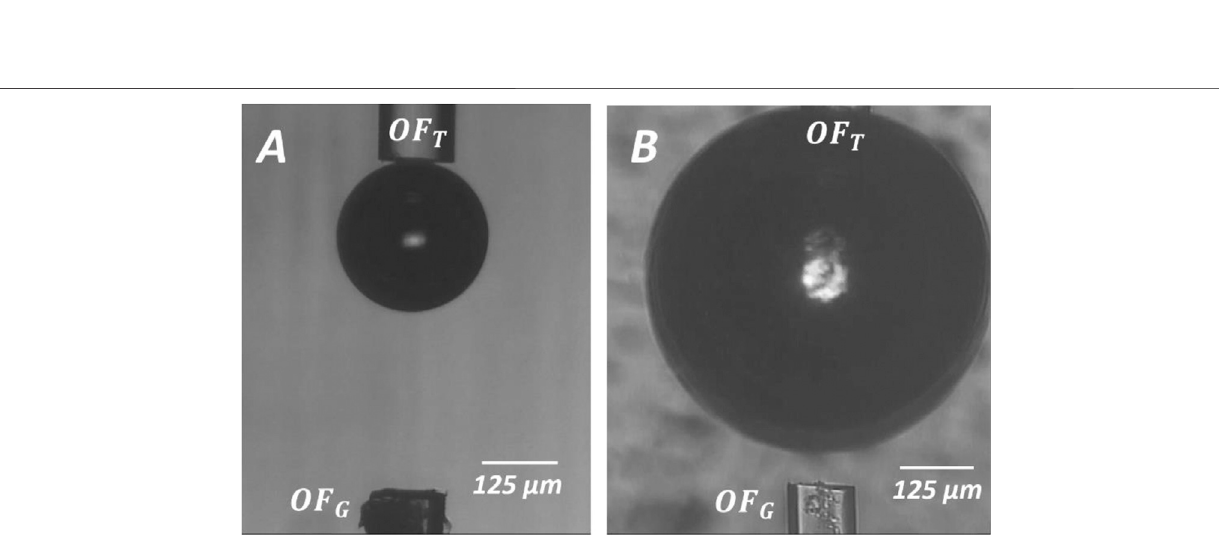
Frontiers in Physics |